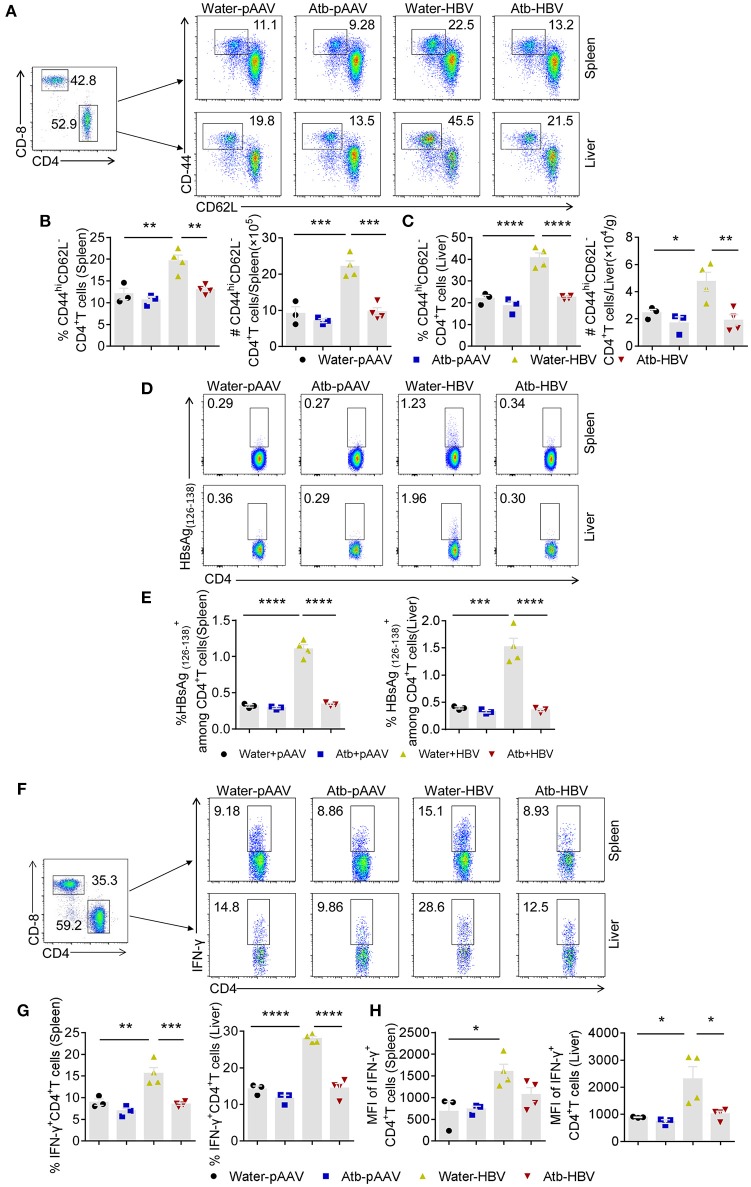
Microbiota depletion reduced amount of effector CD4+ T cells. (A–C) Mice underwent HDI with 6 μg of HBV plasmids or 6 μg of control pAAV plasmids after receiving Atb in drinking water or Atb-free water for 4 weeks. Splenic and hepatic MNCs were isolated for flow cytometry at 4 weeks post-injection (wpi). (A) Dot plots show the percentages of CD44hiCD62L−CD4+ T cells in the liver and spleen. (B) Percentage and number of CD44hiCD62L−CD4+ T cells in the spleen. (C) Percentage and number of CD44hiCD62L−CD4+ T cells in the liver. (D,E) Splenic and hepatic MNCs were isolated for flow cytometry at 6 wpi. (D) Dot plots show the percentages of HBsAg (126-138)+CD4+T cells in the liver and spleen. (E) The percentages of HBsAg (126-138)+CD4+T in the liver and spleen. (F–H) Splenic and hepatic MNCs were isolated for flow cytometry at 4 wpi. IFN-γ expression in splenic and hepatic CD4+ T cells was detected by intracellular cytokine staining. (F) Dot plots show the percentages of splenic and hepatic IFN-γ+CD4+ T cells. (G) Percentages of splenic and hepatic IFN-γ+CD4+ T cells. (H) Mean fluorescence intensity (MFI) of splenic and hepatic IFN-γ+CD4+ T cells. (B,C,E,G,H) Each point represents one mouse. The data are representative of more than three independent experiments. Results are presented as the mean ± SEM (n ≥ 3 mice/group) and one-way ANOVA test was used. *p < 0.05, **p < 0.01, ***p < 0.001, ****p < 0.0001.